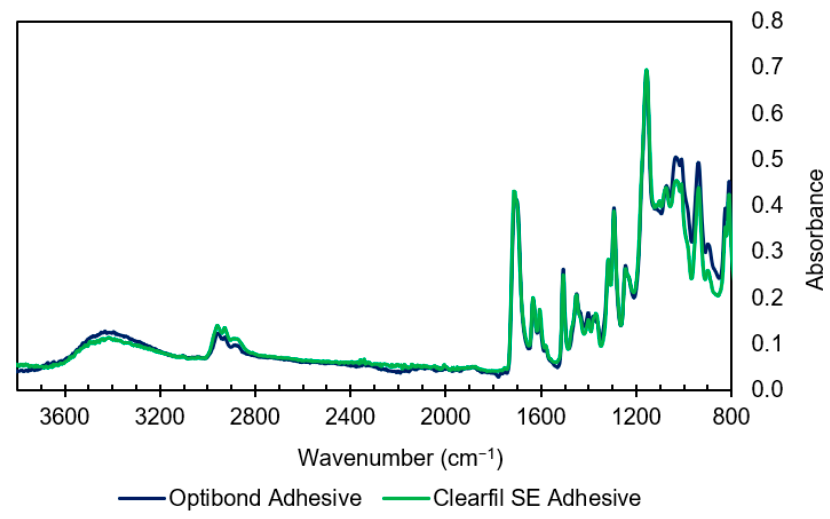
Figure 4. Comparison of IR spectra of both adhesives. The mixtures appear to be similar except in the 1000–900 cm − 1 region which can be due to differences in filler load and also the fraction of monomers such as HEMA and GDMA.